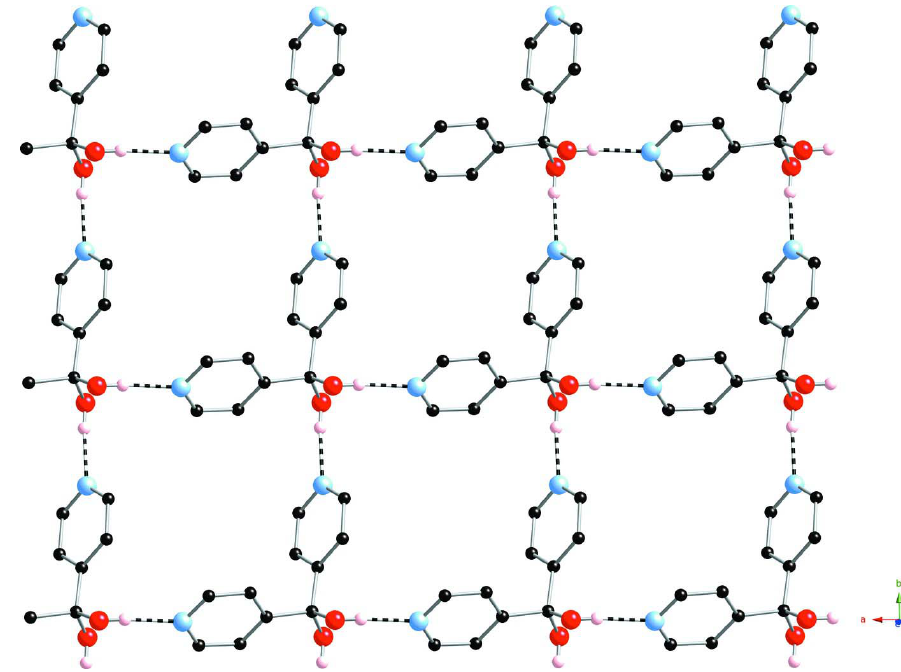
Figure 2 A view down c showing the aggregation of molecules of the title compound into a (4,4) square grid. Hydrogen bonding is indicated as dashed